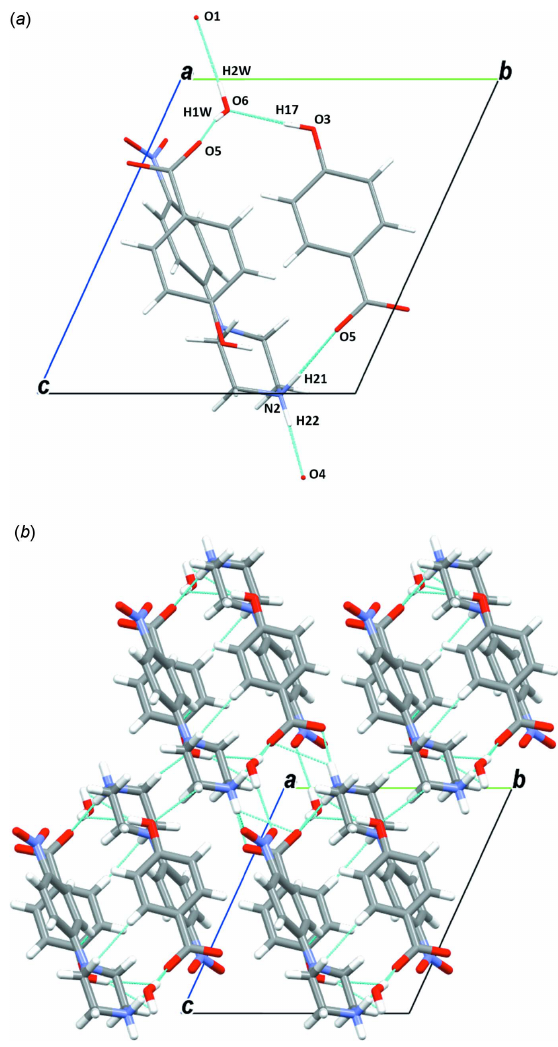
Figure 10 ( a ) A general view of the main intermolecular interactions (N—H (cid:2)(cid:2)(cid:2) O and O—H (cid:2)(cid:2)(cid:2) O) in (IV) and ( b ) the molecular packing of (IV) with hydrogen bonds shown as dashed lines.